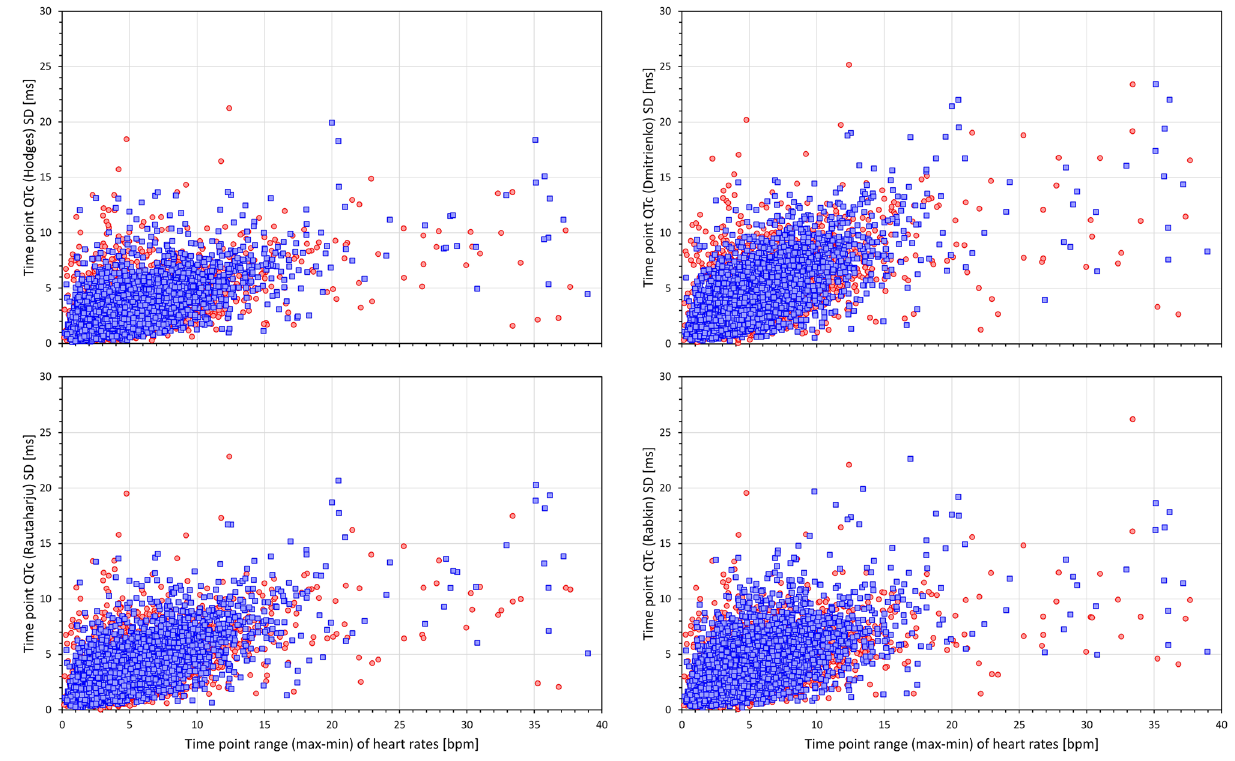
Figure 7. Scatter diagrams between heart rate ranges (max–min) and standard deviations of QTc values of individual study time-points. The left top, top right, bottom left, and bottom right panels show the relationship for Hodges, Dmitrienko, Rautaharju, and Rabkin corrected QTc intervals, respectively. In all panels, all time- points of all study subjects are pooled together, red and blue marks show the data of female and male subjects, respectively. Outliers beyond the ranges of the axes were also present in the data. The abbreviations and meaning of panels are the same as in Fig. 6. The note in the caption of Fig. 6 also applies—compare the panels with panels of Fig. 6.